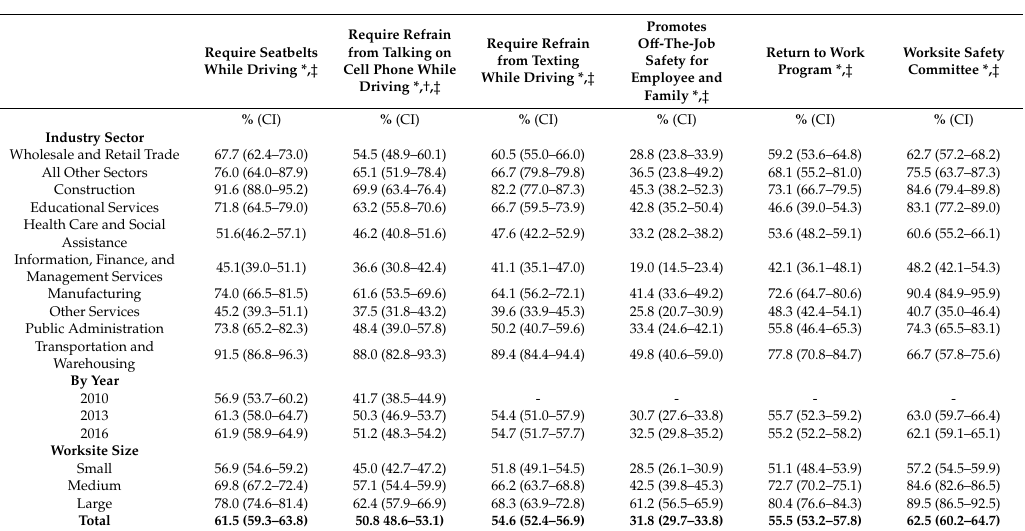
Table 4. Weighted percentage of worksites that responded “Yes” to implementing workplace safety policies, by industry sectors, survey years, and worksite